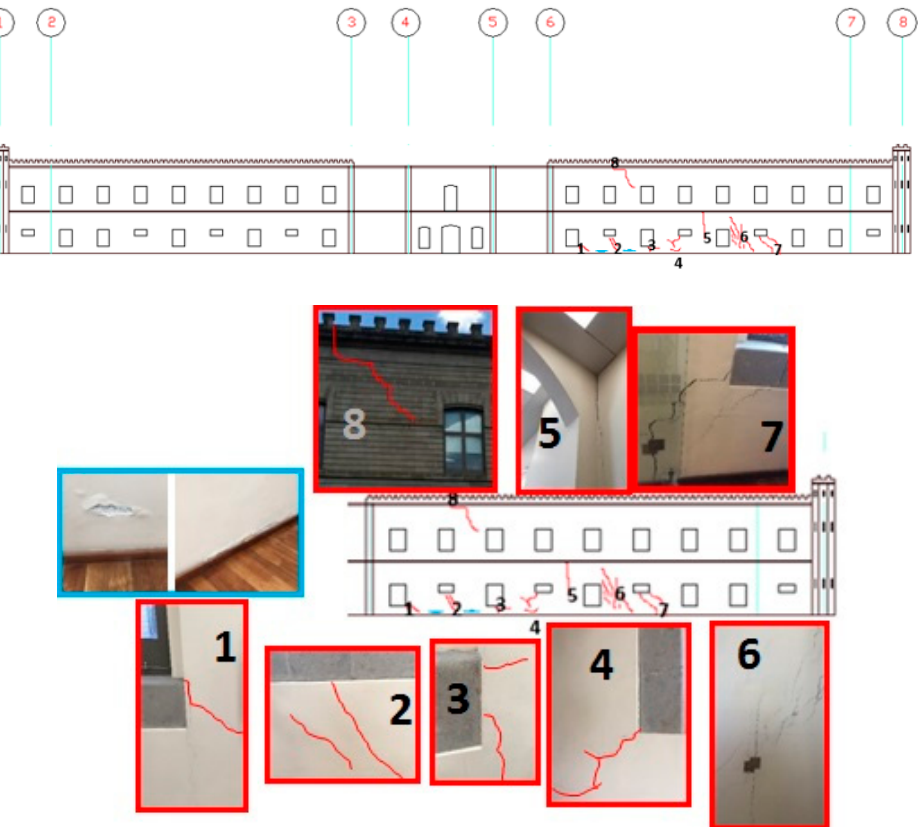
Figure 5. Layout of the damage survey on axis C [9].